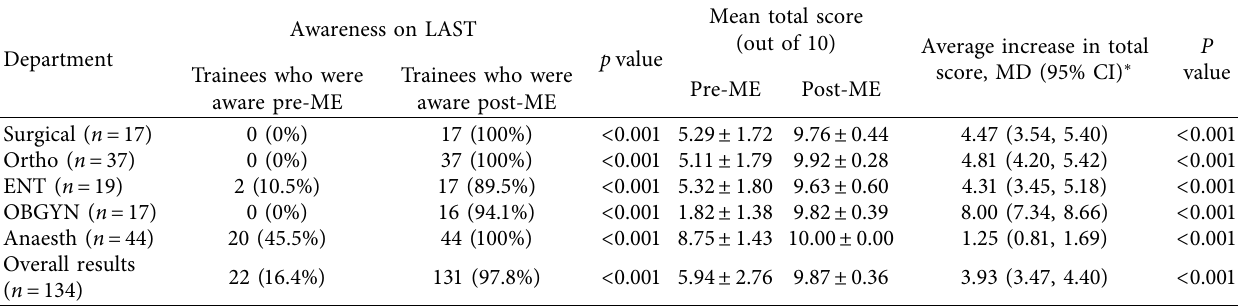
Table 2: Comparing awareness and mean total scores (out of a maximum of 10) before ME and after